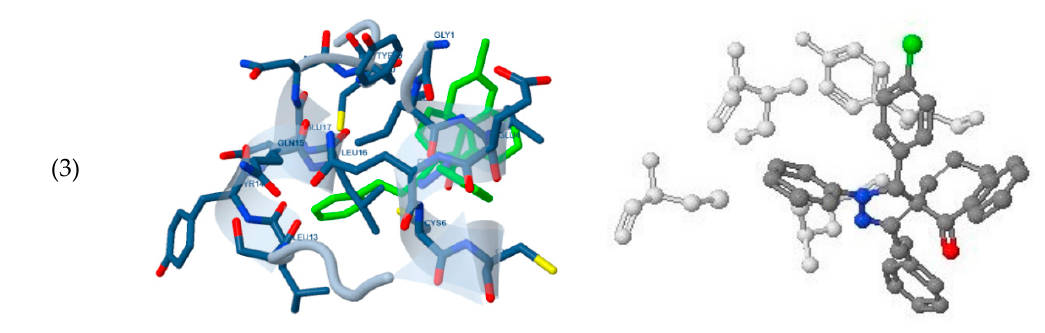
Figure 5. Spiropyrazoles derivatives (green in ( A ) and gray in ( B )) in interaction with 3tt8 receptor. (For interpretation of the references to color in this figure legend, the reader is referred to the web version of this article).